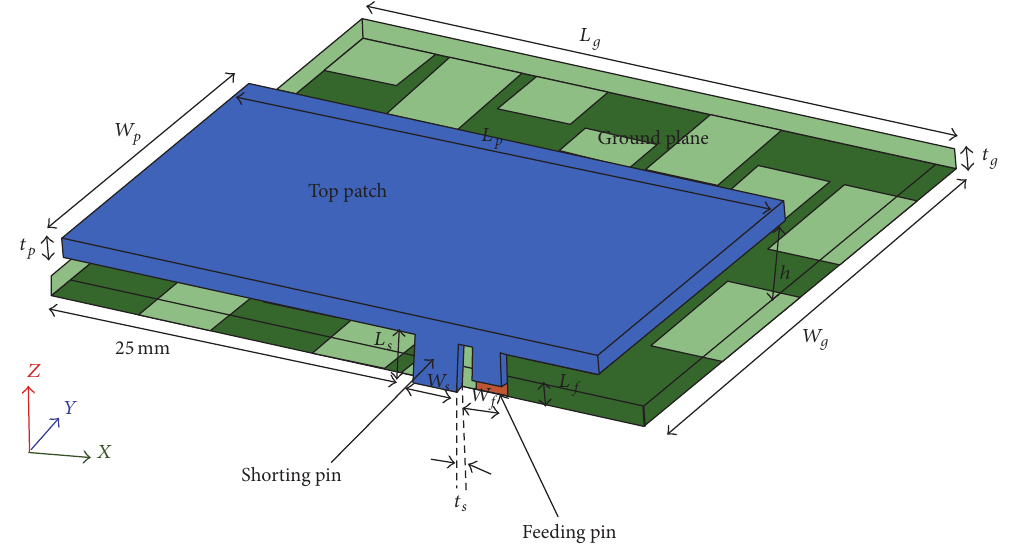
Figure 2: The geometry of the proposed triband PIFA structure.